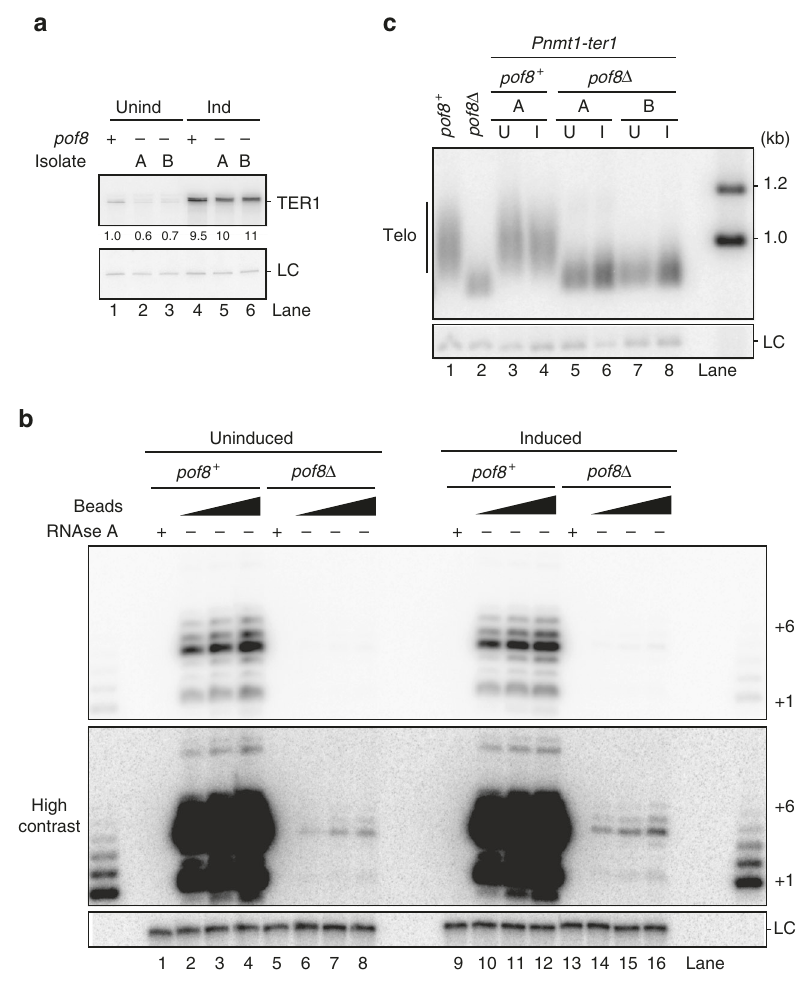
Fig. 3 TER1 overexpression fails to rescue telomerase defects in pof8 Δ cells. a Northern blot analysis of total RNA isolated from cells expressing TER1 from a plasmid under the control of uninduced (Unind) and induced (ind) nmt1 promoter in an Lsm4-cMyc background. Two independent isolates (A and B) of pof8 Δ transformants were used. Uninduced cells were grown in YES (with thiamine) and in EMM (no thiamine) for the induced condition. The lower panel shows snR101 probed as a loading control (LC). Uncropped blots are presented in Supplementary Fig. 3b. b Telomerase activity assay from Lsm4-cMyc immunoprecipitates from pof8 + and pof8 Δ cells harboring nmt1-TER1 grown under uninduced and induced conditions. A high contrast version of the top panel is included to visualize the low levels of telomerase activity from pof8 Δ cells. Ladder of extension products generated by terminal transferase is fl anking the assay as size markers; the bands corresponding to +1 and +6 nucleotide addition products are indicated. A 32 P-labeled 100-mer oligonucleotide was used as LC. Uncropped blot is presented in Supplementary Fig. 3b. c Southern blot analysis of telomere length of strains described in a and controls. U uninduced, I induced. A probe for the rad16 + locus was used as the